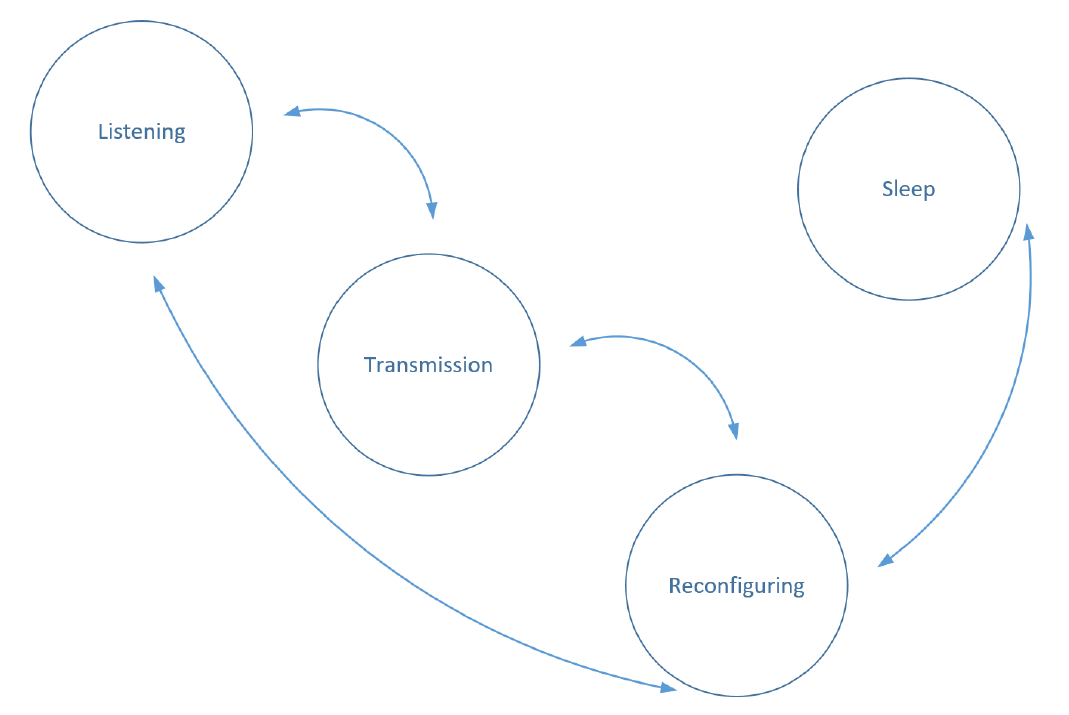
Figure 3. Sensor node